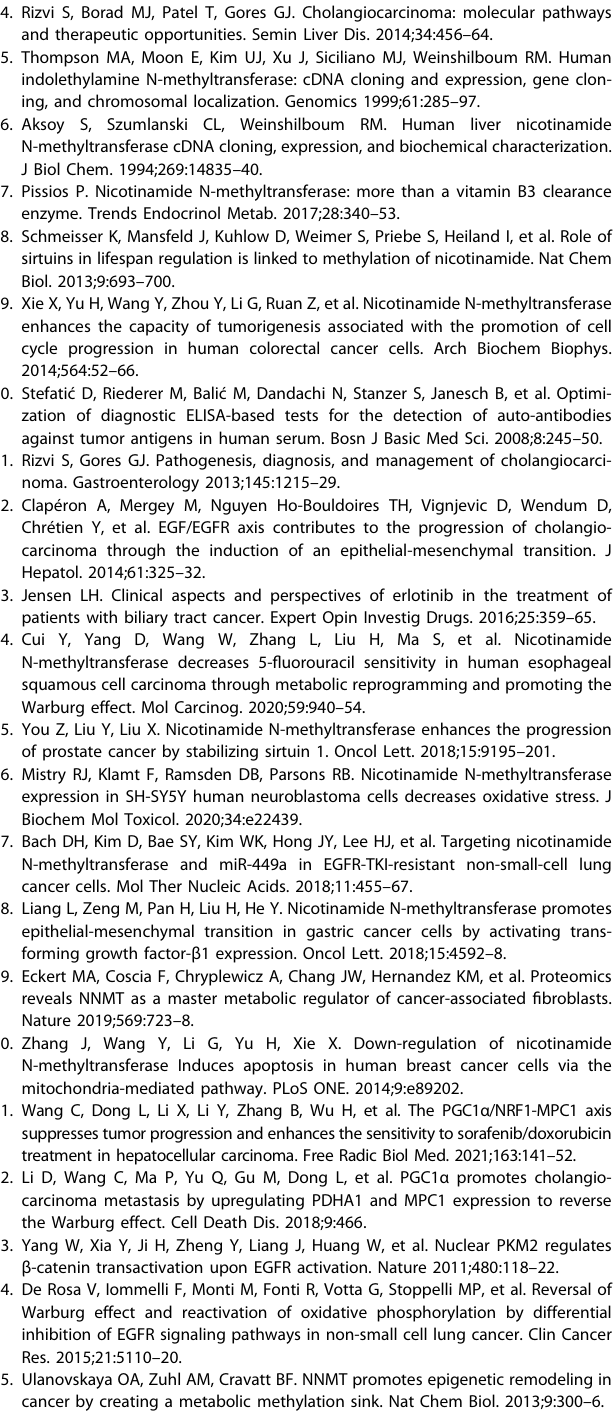
Fig. 7 NNMT regulates the Warburg effect in iCCA through the EGFR-STAT3 axis. A The expression level of EGFR-related signaling proteins in the cells was measured using western blotting. B After treatment with 10 μ M erlotinib, the levels of EGFR, p-EGFR, and p-STAT3 in the cells were determined using western blotting. C Colony formation assay using the cell line treated with 5 μ M STATTIC. D Migration test after treatment of the cell line with 5 μ M STATTIC. E Invasion test after treatment of the cell line with 5 μ M STATTIC. Scale bars: 100 μ m. F The effect of NNMT on the mRNA levels of the key enzymes involved in glycolysis. G The effect of 5 μ M STATTIC on the mRNA levels of the key enzymes involved in glycolysis in cell lines overexpressing NNMT. H The Seahorse X96 analyzer detects the ability of iCCA cell lines to excrete acid and the oxygen consumption rate after treatment with 5 μ M STATTIC. I Schematic presentation of the pathway by which NNMT facilitated iCCA proliferation and metastasis (data are mean ± SEM, * P < 0.05, ** P < 0.01, *** P < 0.001, n =